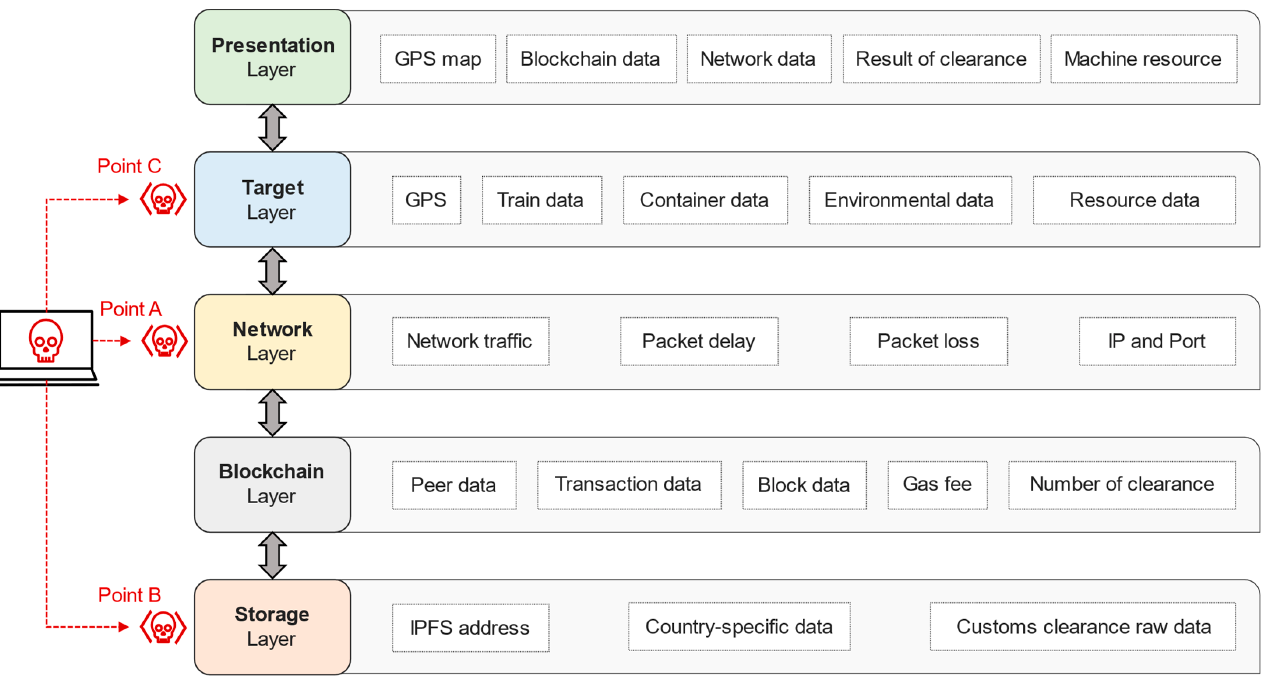
Figure 3. Data derived for each component layer.